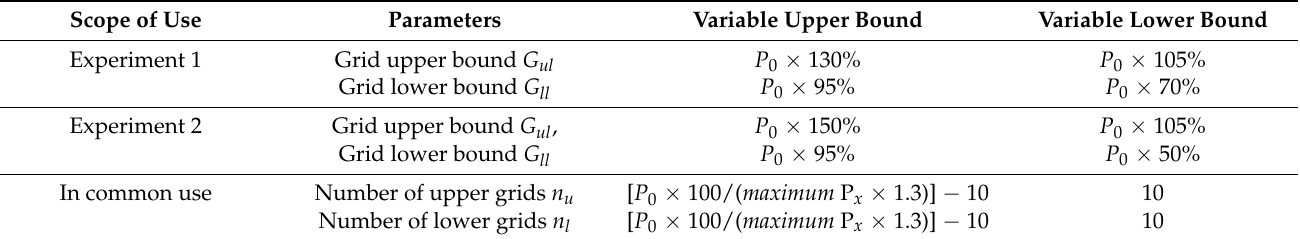
Table 1. Upper and lower bounds of grid trading parameters.